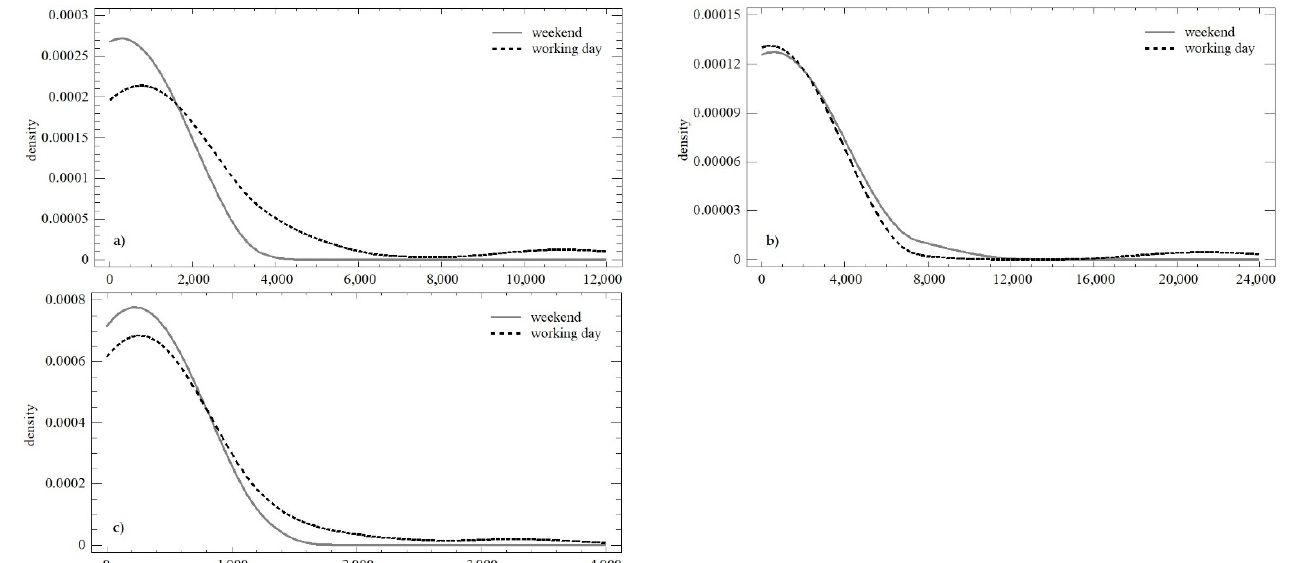
Figure 9. Density plot of the numbers of shares in three observation periods: ( a ) observation no. 1; ( b ) observation no. 2; ( c ) observation no. 3. Table 6. Comparison of the trend level (regressor) of the regression model.